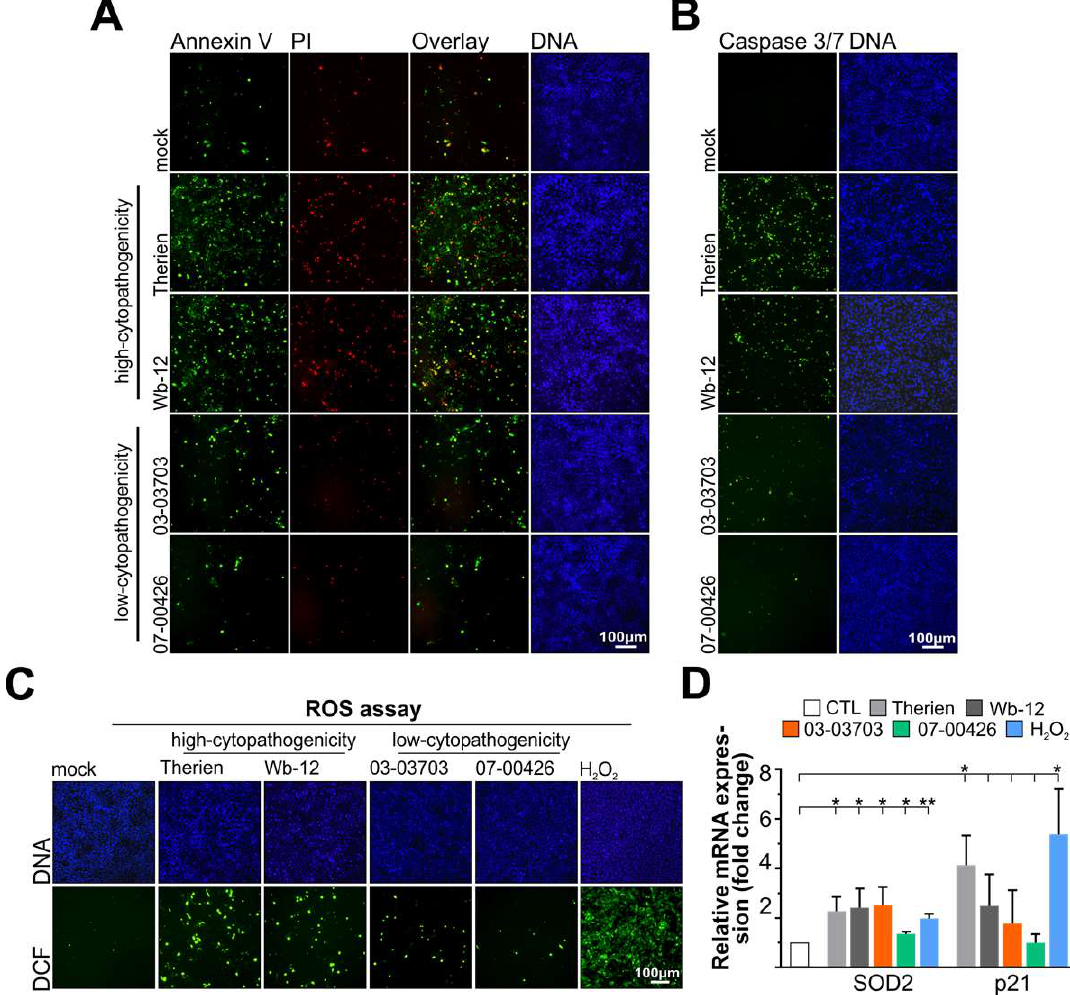
Figure 1. Comparative analysis of the capacity of different rubella virus (RV) strains to induce apoptosis and evoke an oxidative stress response in Vero cells. ( A – C ) At 3 days post-infection (dpi), RV strain-specific differences in apoptosis induction were assessed through fluorescence microscopy of ( A ) early (Annexin V-Alexa 488-positive cells) and late (Annexin V-Alexa 488- and propidium iodide (PI)-positive cells) apoptotic response and ( B ) activation of caspase 3 and 7 activity through monitoring nuclear accumulation of the fluorophore after DEVD cleavage; ( C ) Reactive oxygen species (ROS) generation was monitored at 3 dpi in Vero cells infected with indicated RV strains through fluorescence microscopy of the dichlorofluorescein (DCF) fluorescence; ( D ) The mRNA expression level of the mitochondrial antioxidant enzyme superoxide dismutase 2 (SOD2) and the oxidative stress-sensitive protein p21 was validated by quantitative real-time PCR (qRT-PCR). Hydrogen peroxide (H 2 O 2 ) was used as positive control and applied for 5 h at a 1:5000 dilution. CTL, control. *, p < 0.05; **, p < 0.01.